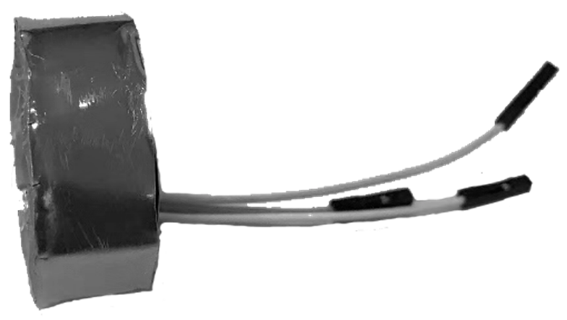
Figure 10. Prototype